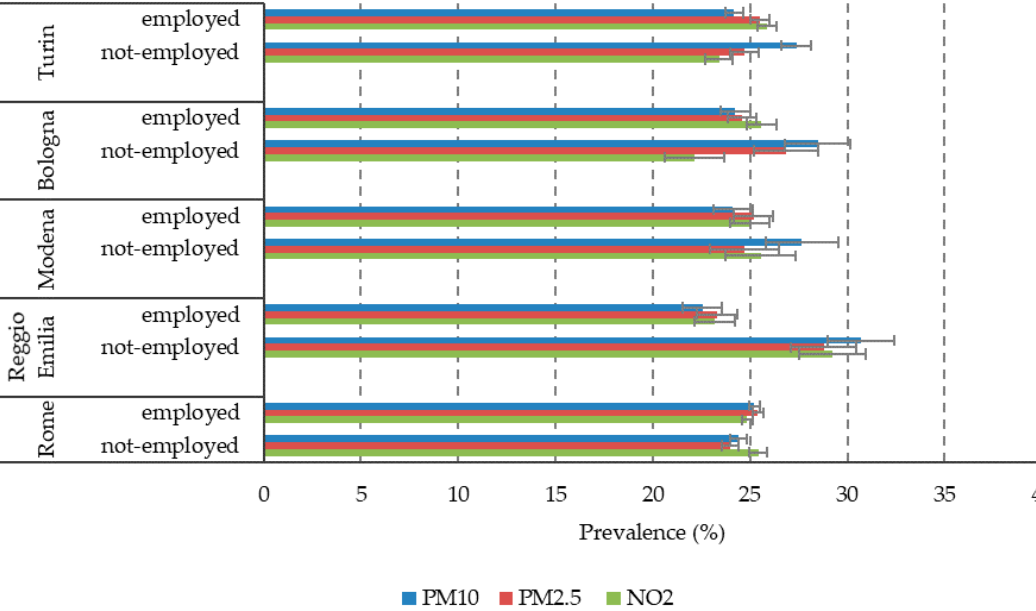
Figure 3. Prevalence of high air pollution exposure (>75th percentile) by city and maternal citizenship.